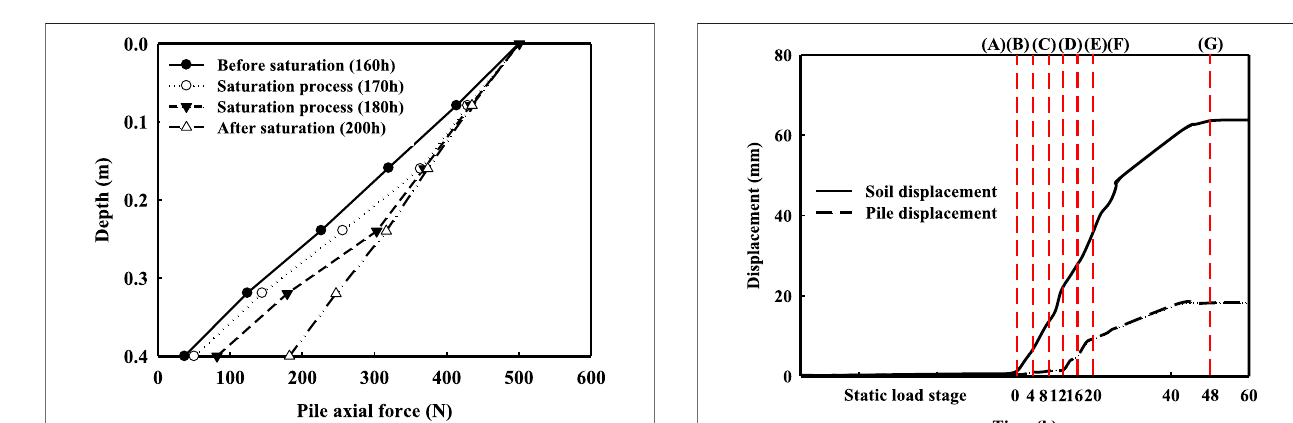
FIGURE 10 | Variations of soil and pile head displacement with the time of